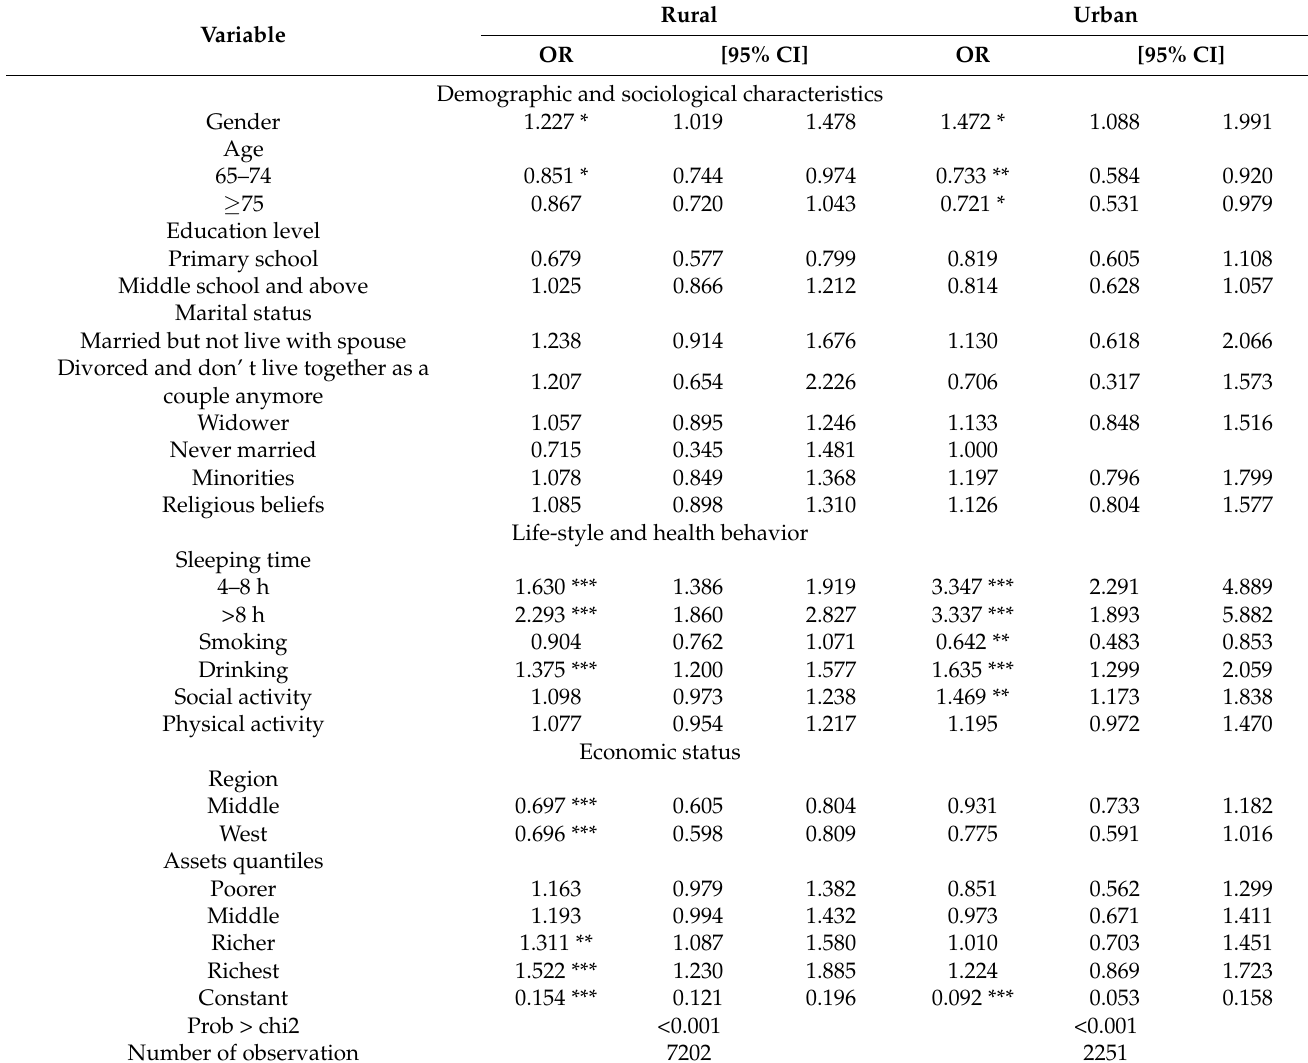
Table 4. Logit regression results of the SAH in the rural and urban elderly.